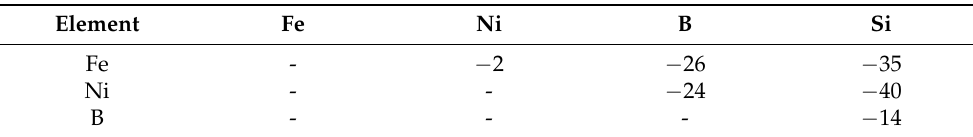
Table 2. The chemical mixing enthalpy ( ∆ H mix approach